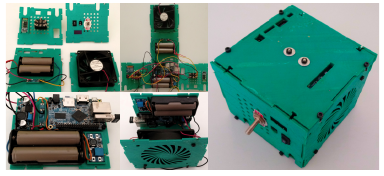
Figure 30. Connections and electronics.